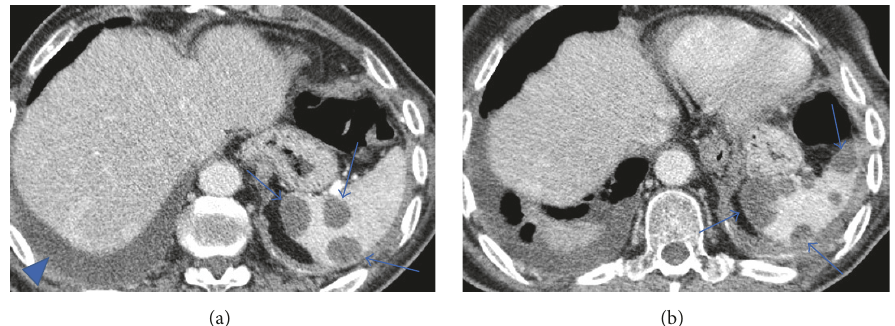
Figure 13: Multislice chest CT. Axial images on mediastinal window at the pulmonary bases (a and b) show increase in size and number of the nodular spleen lesions (arrows). A pleural effusion in the right side is also apparent